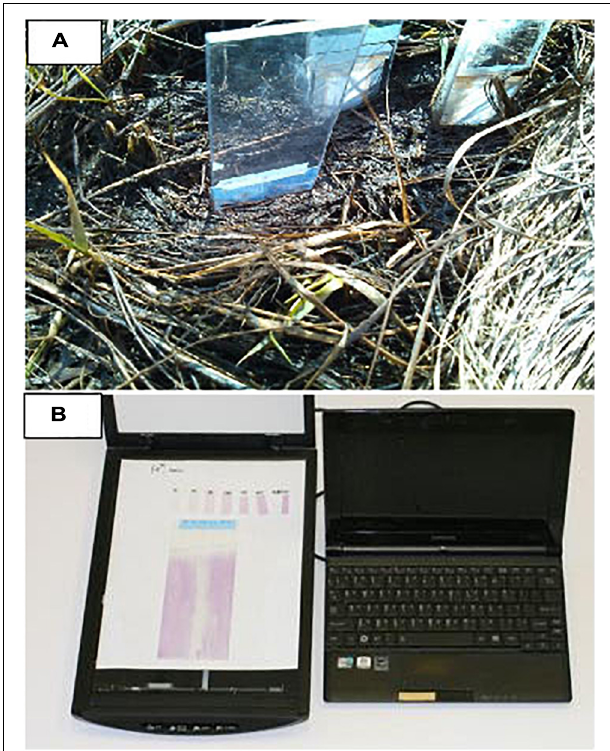
FIGURE 2 | (A) In situ deployment of planar optical sensors of Fe 2 + and H 2 S in salt marshes. The sensor sheet strip was mounted on a polycarbonate plastic sheet with a beveled end and inserted into the marsh for a certain time. (B) The 2-dimensional sensing image associated with calibration strips was recorded with a flat scanner (Canon). Reprinted from Encyclopedia of Ocean Sciences, 3rd edition, vol. 4. Zhu Q., In situ Planar Optical Sensors for Sediment Diagenesis Study, pp. 147–156, Copyright 2019, with permission from